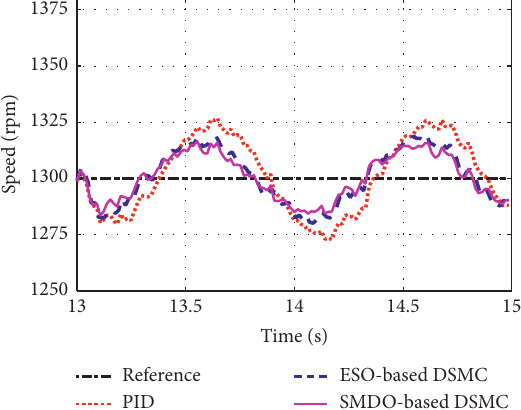
Figure 12: Diesel engine speed response under periodic disturbance